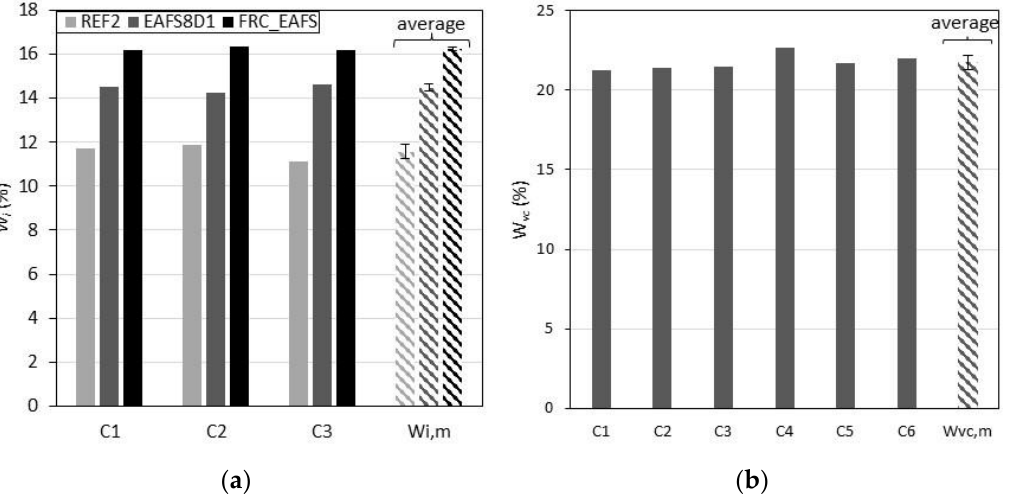
Figure 18. Results of water absorption by immersion: ( a ) for REF2, EAFS8D1 and FRC_EAFS mixtures at atmospheric pressure; ( b ) for EAFS8D1 under vacuum.